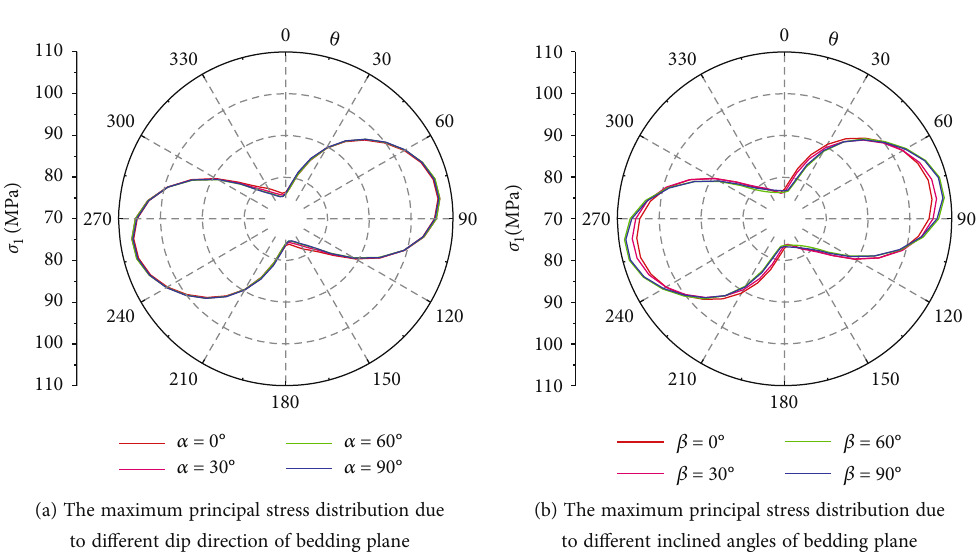
Figure 6: In fl uence of the inclined property of bedding plane on the principal stress at the borehole